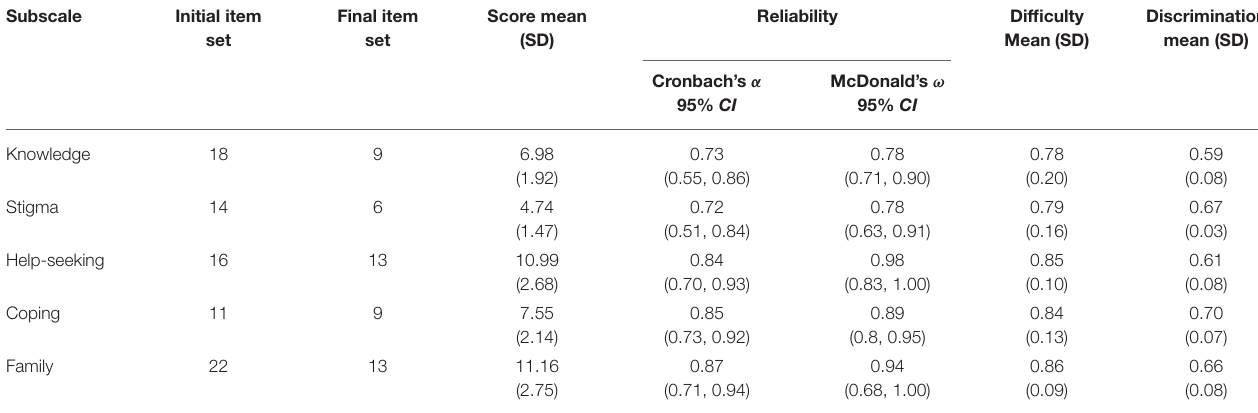
TABLE 3 | Subscale